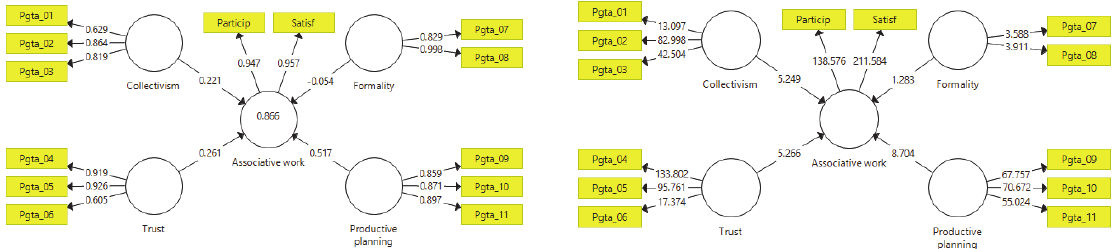
Fig. 2. Results for the hypothesized model with structural equations